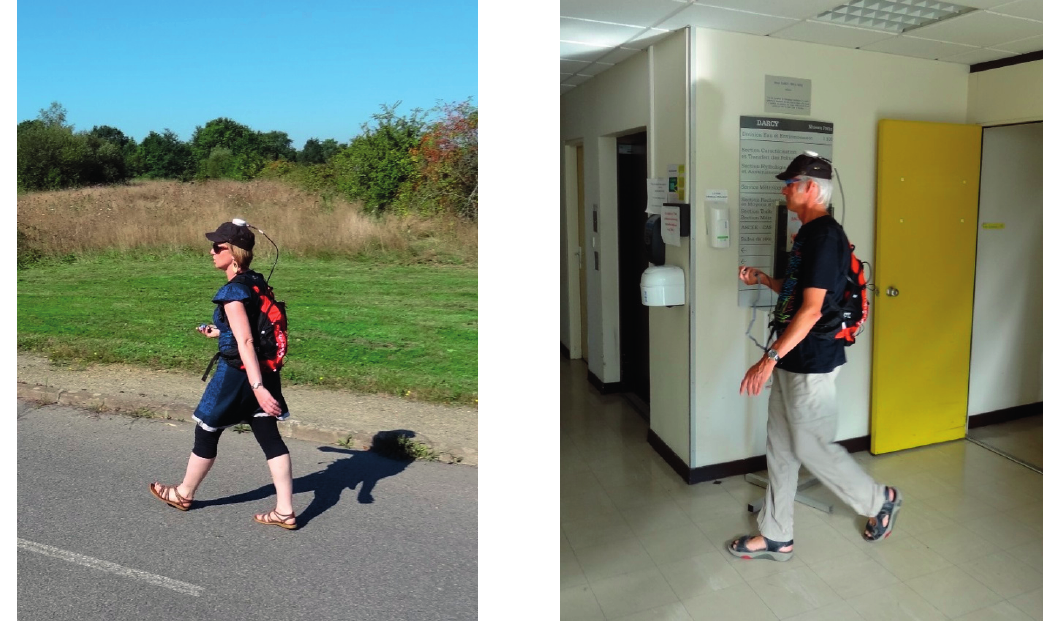
Figure 8. Experimental test